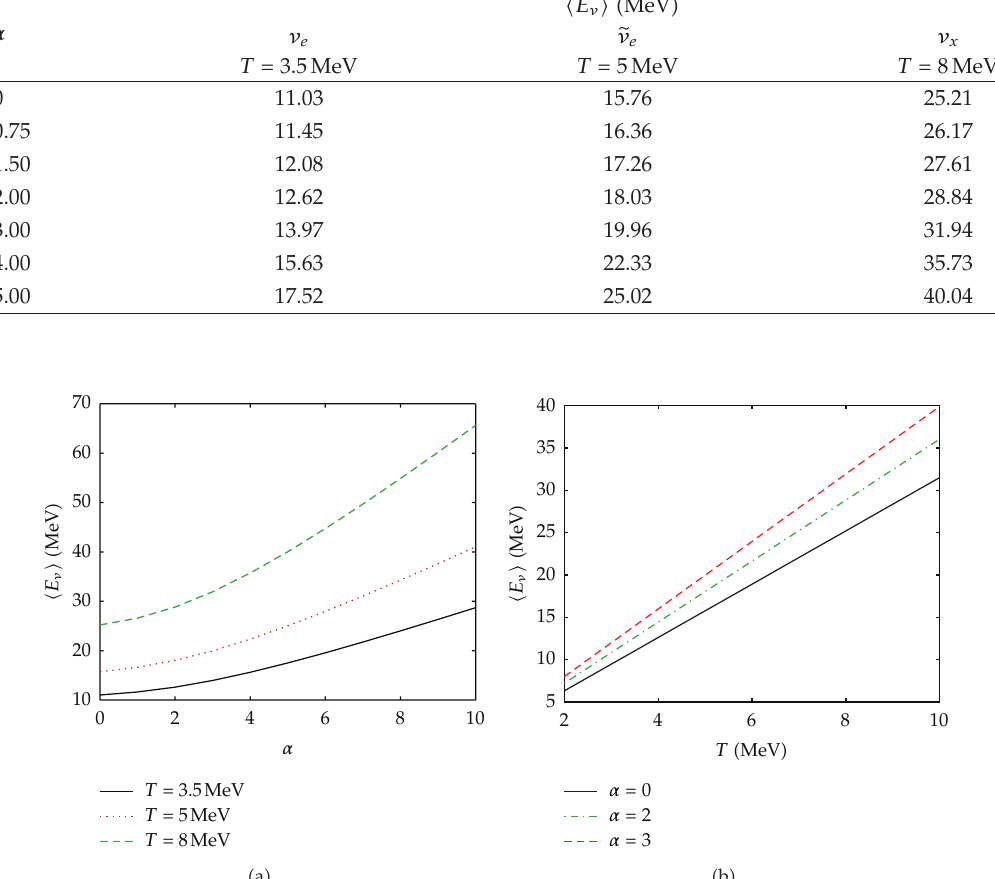
Figure 3: (cid:3) Color on line (cid:4) . Averaged neutrino energy as a function of the parameter α for various temperatures T (cid:3) a (cid:4) . Averaged neutrino energy as a function of temperature for various parameters of chemical potential α (cid:3) b (cid:4)